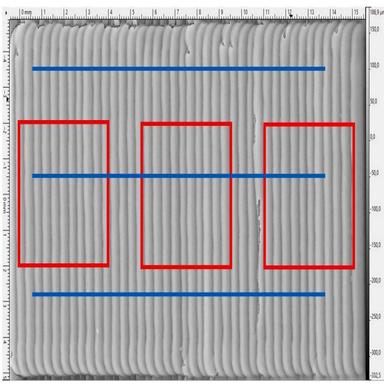
Example of selected areas for surface evaluation. Linear profiles (blue), areas (red).